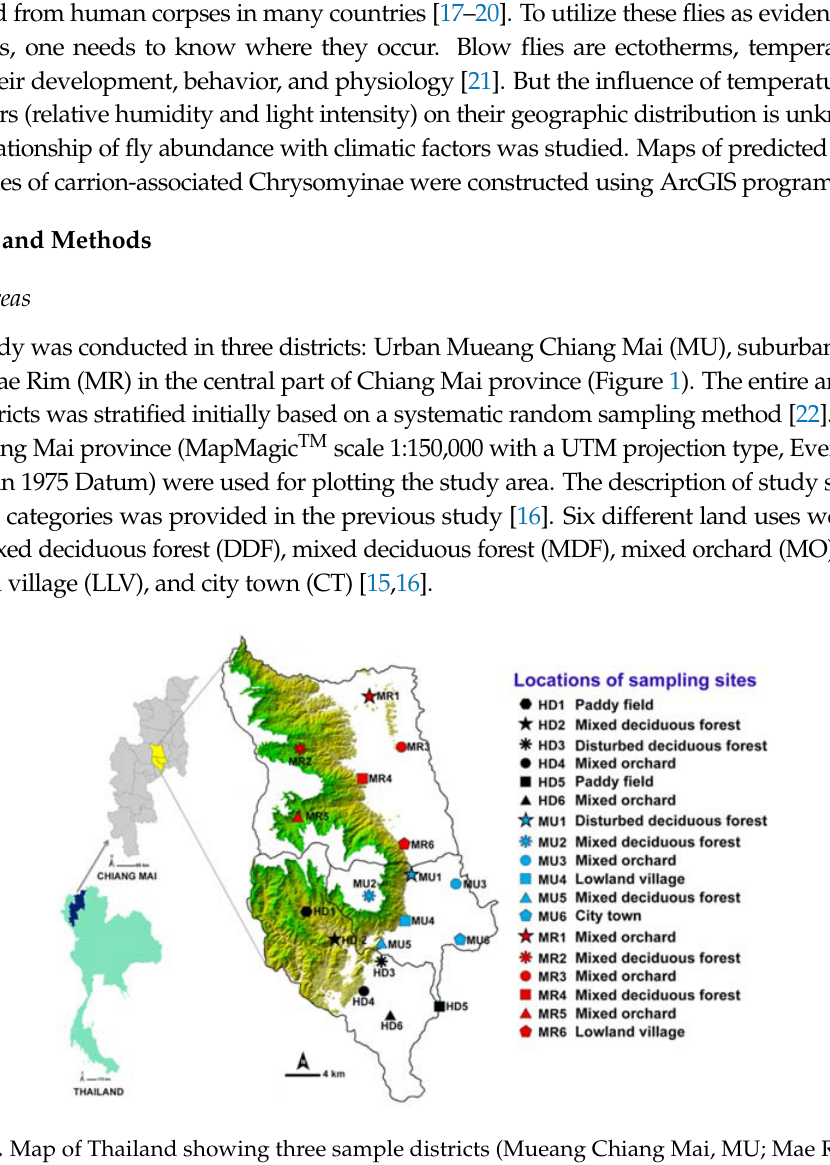
Figure 1. Map of Thailand showing three sample districts (Mueang Chiang Mai, MU; Mae Rim, MR; and Hang Dong, HD) and 18 sampling locations. Green shade represents a mountainous area.